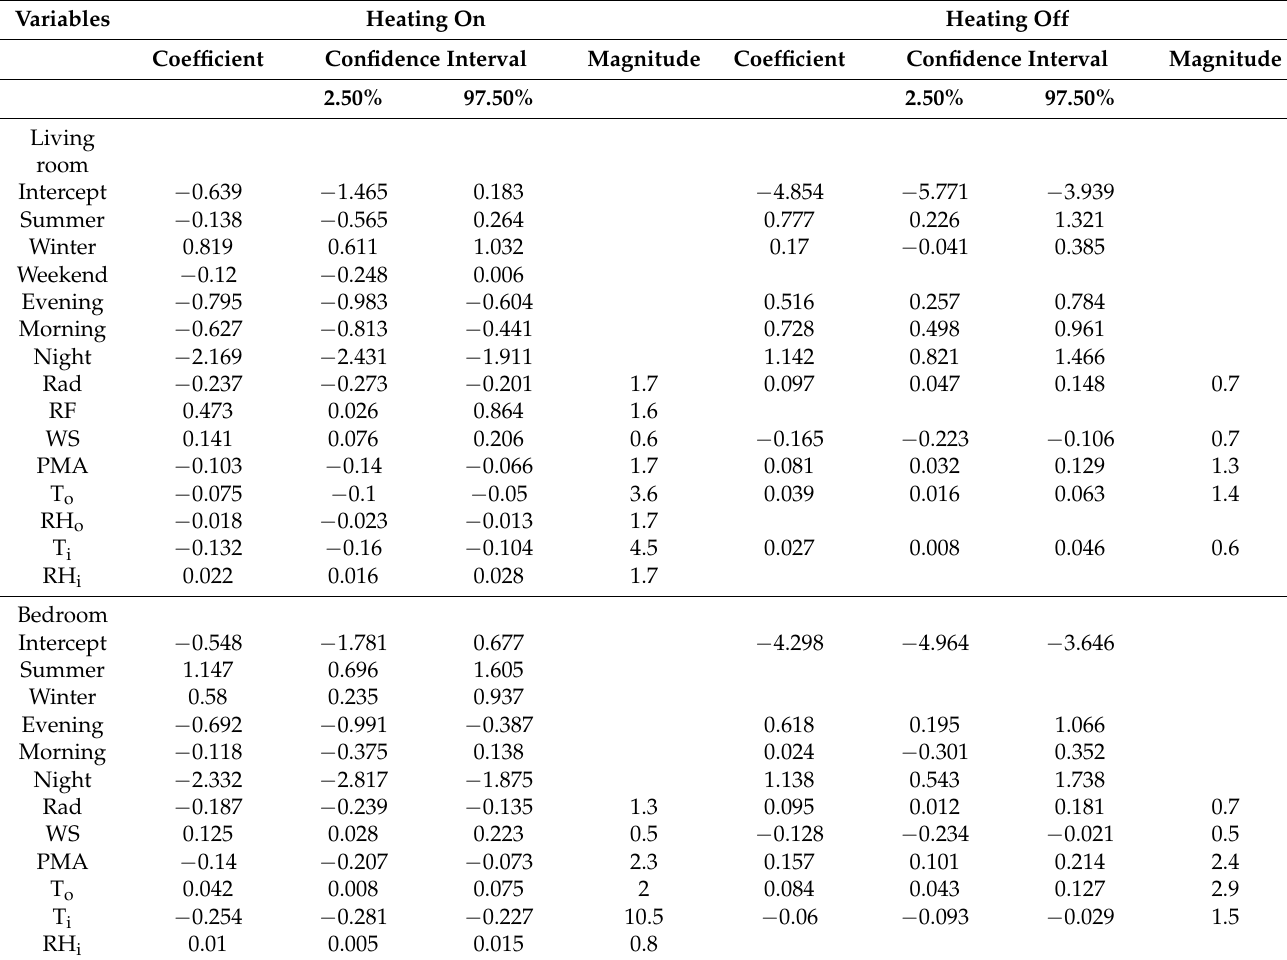
Table 8. Coefficients and magnitudes of variables inferred from heating on and off